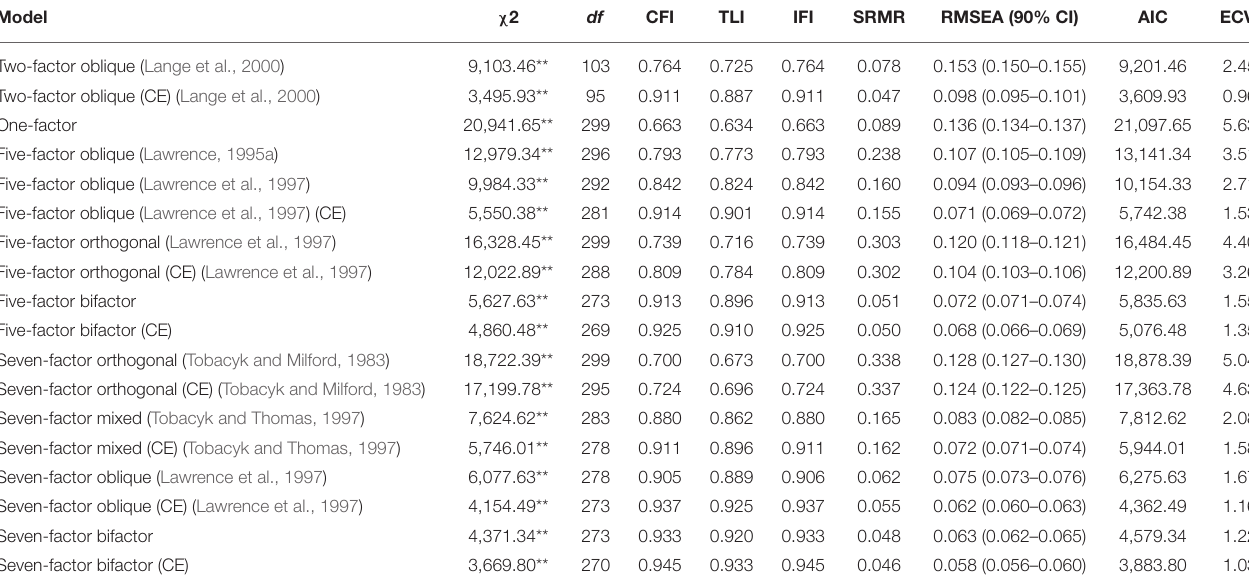
TABLE 3 | Fit indices for competing RPBS factor